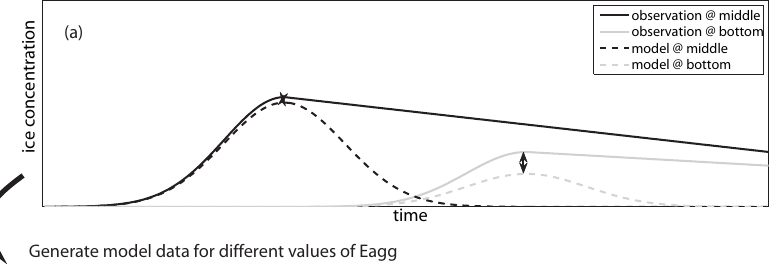
Fig. 5. A schematic of the technique used to find the maximum likelihood estimate and confidence interval of the aggregation efficiency for each experiment. Panel (a) shows a schematic of the observation of ice crystal number at the middle and at the bottom of the chamber, plus the modelled ice concentration for the same positions within a model simulation with an guess for the E agg parameter. The “goodness-of-fit” is calculated, which is the sum of the residual differences squared for both observation levels. This is done for different values of the E agg parameter as input into the model, so that a graph of the goodness-of-fit vs. E agg can be produced (b) ; the minimum value of the goodness- of-fit on this graph is the best estimate for E agg . Monte Carlo simulation is then used to generate the cumulative fraction of goodness-of-fits (c) and then a significant level for the error bar is assigned (25%) to find the critical value of the goodness-of-fit above which the observation and model are significantly different. Remapping this to the graph of goodness-of-fit vs. E agg gives the confidence interval for E agg (d)